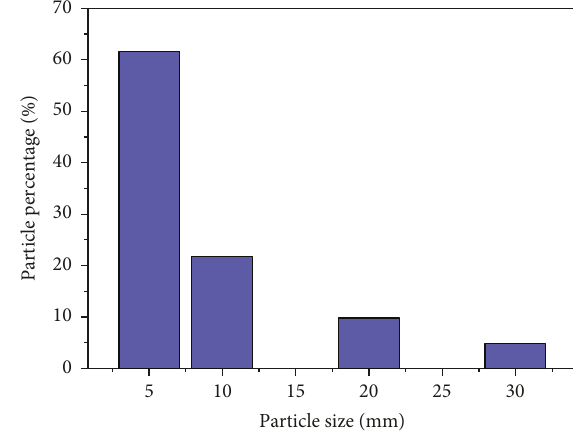
Figure 9: Subsidence velocity curve comparison at point L in the middle of the